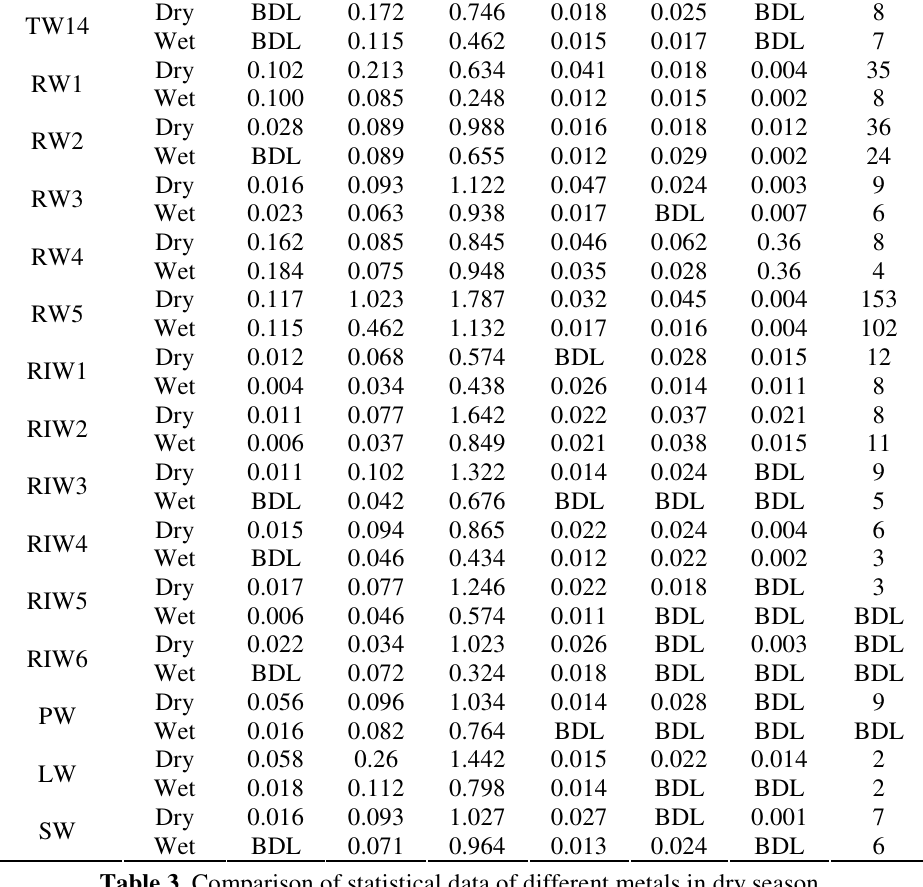
Table 3. Comparison of statistical data of different metals in dry